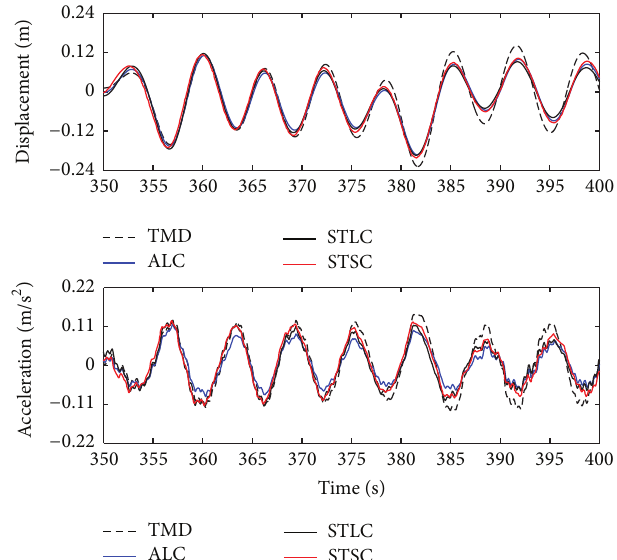
Figure 6: Comparison of the 75th storey Response ( 0 % stiffness variation).